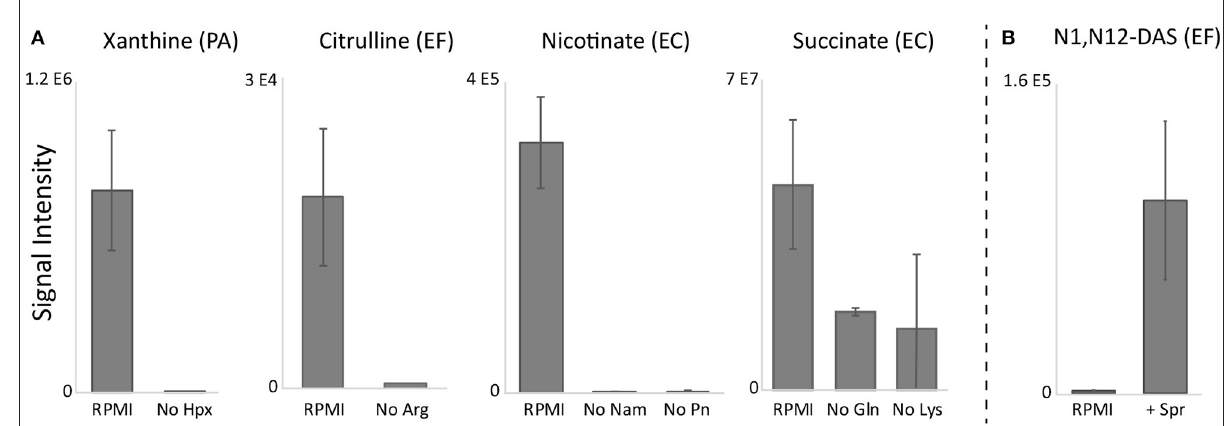
FIGURE5 RPMI precursor exclusion (A) and supplementation (B) results. Exclusion of hypoxanthine (Hpx), arginine (Arg), and nicotinamide (Nam) or pyridoxine (Pn) in RPMI eliminated species-specific production of xanthine, citrulline, and nicotinate, respectively, while exclusion of glutamine (Gln) and lysine (Lys) decreased EC succinate production. Supplementation of RPMI with spermine restored N 1 ,N 12 -diacetylspermine (N1,N12-DAS) production. RPMI, Roswell Park Memorial Institute medium; PA , Pseudomonas aeruginosa ; EF , Enterococcus faecalis ; EC , Escherichia coli . Data are presented as mean values + / − SD of n = 3